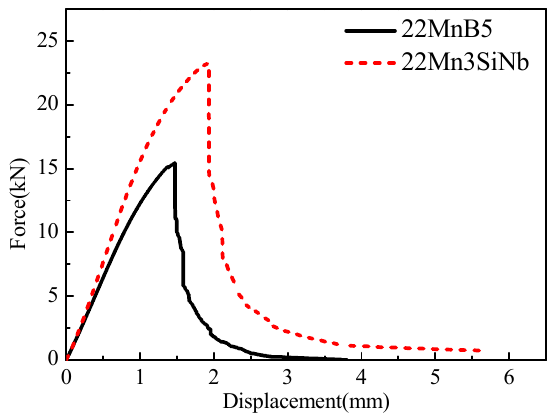
Figure 9. The force ‐ displacement curves of the Kahn tear test. Figure 9. The force-displacement curves of the Kahn tear Table 4. Tear properties of two investigated steels.